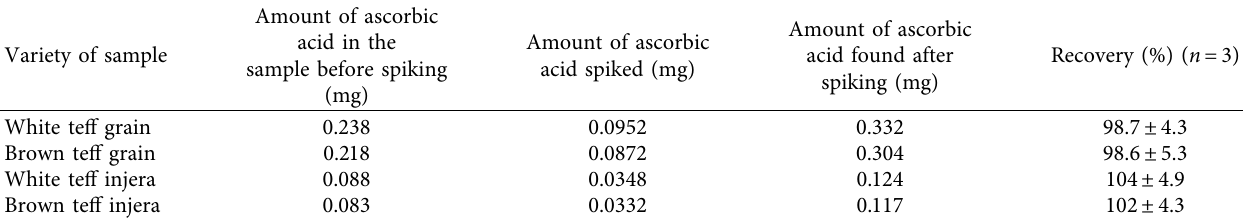
Table 3: Recovery results of ascorbic acid by the redox titration method.